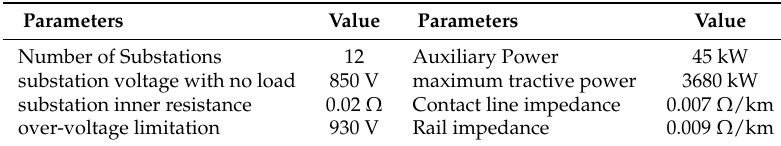
Table 5. Substation-related